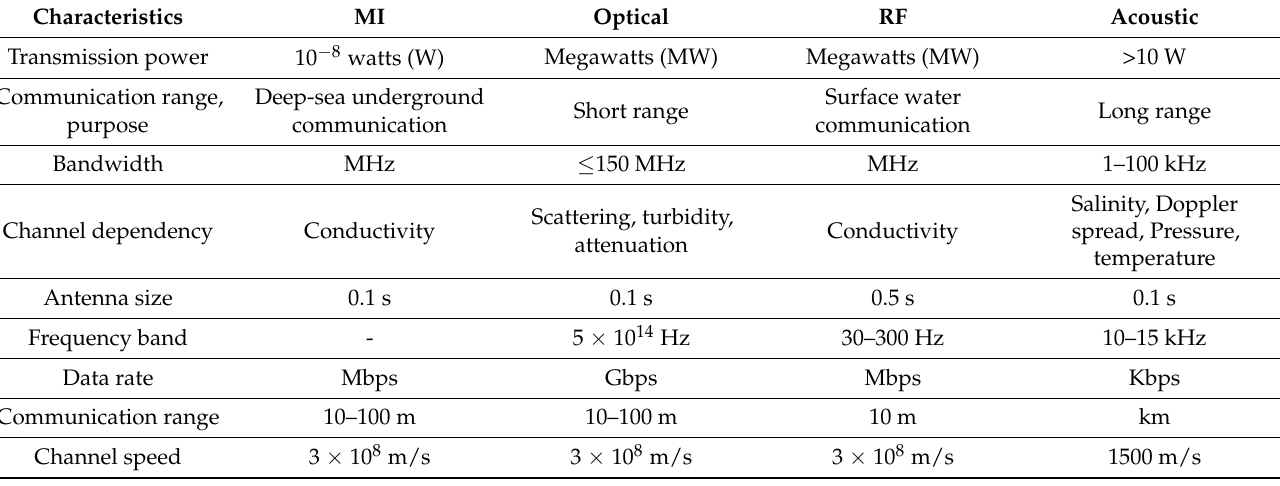
Table 4. Communication Technologies used in the IoUT